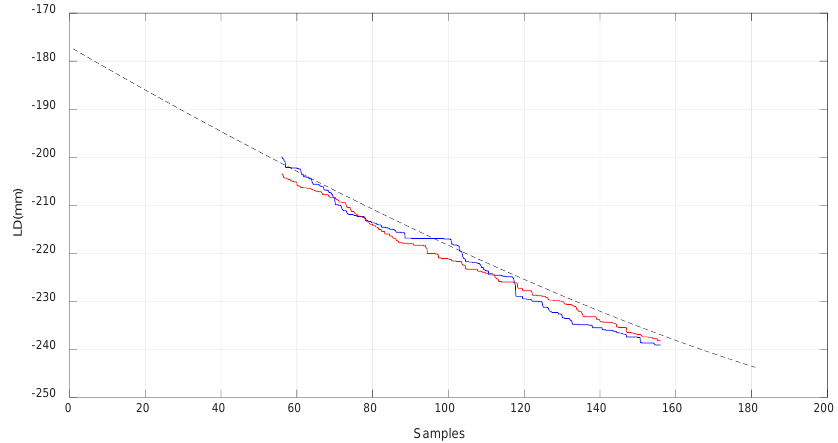
Figure 19. Comparison of the simulated and real world results for l A . The dotted line corresponds to the simulated results with MSC ADAMS. The red line corresponds to the value of l A in an experiment where EE 2 goes up from its lower position. The blue line corresponds to the value of l A in an experiment where EE 2 goes down from its upper position.